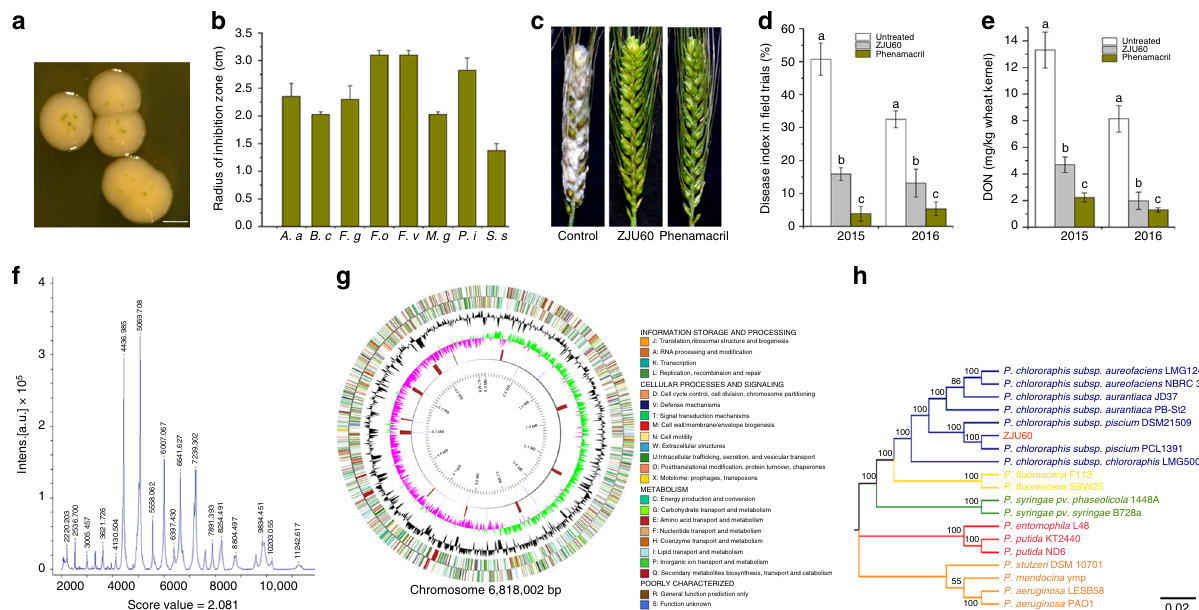
Fig. 1 Isolation and identi fi cation of ZJU60 for FHB control. a Colony morphology of ZJU60 on King ’ s B agar medium after 5 days of incubation at 30 °C. Bar = 1 mm. b Antagonistic activity of ZJU60 against eight important plant pathogenic fungi. The radius of inhibition zone (centimeter, cm) was measured for each co-culture of ZJU60 with Alternaria alternata ( A. a ), Botrytis cinerea ( B . c ), Fusarium graminearum ( F . g ), Fusarium oxysporum ( F . o ), Fusarium verticillioides ( F . v ), Magnaporthe grisea ( M . g ), Penicillium italicum ( P. i ), and Sclerotinia sclerotiorum ( S. s ). c Biocontrol ef fi cacy of ZJU60 against FHB in a growth chamber. The fungicide phenamacril was used as a control. d The disease index of FHB after treatment with ZJU60 or fungicide in fi eld trials conducted in 2015 and 2016. Water was used for the untreated control. e Ef fi ciencies of ZJU60 and phenamacril in controlling DON production in fi eld trials. Data presented are the mean ± s.d. ( n = 3). Bars followed by the same letter are not signi fi cantly different according to a Fisher ’ s least signi fi cant difference (LSD) test at P = 0.05. f ZJU60 pro fi le generated by the high-throughput MALDI Biotypersmart system. g The circularized genome map of Pseudomonas chlororaphis subsp. piscium ZJU60. The outermost and second circles of all replicons indicate genes in forward and reverse orientations, and are color-coded by their role categories. The third circle shows G + C content in black and the fourth circle shows the G + C skew in green ( + ) and purple ( − ). The fi fth circle shows the insertion sequences in red, putative prophage remnants in brown, and MITEs in blue. The scale is shown in the innermost circle. h A phylogenetic tree of ZJU60 with the other completely sequenced representatives of Pseudomonas spp. strains using ten housekeeping genes as phylogenetic markers. The signi fi cance of each branch is indicated by a bootstrap value calculated for 1000 subsets. Bar, 2 nucleotide substitutions